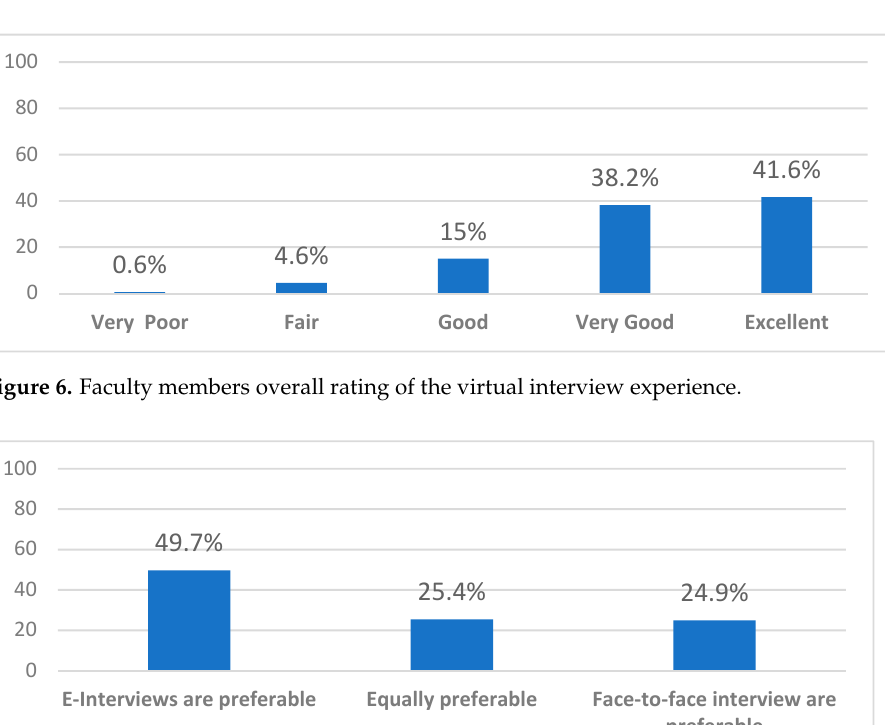
Figure 5. Faculty members’ (mean) satisfaction rate with virtual interviews domains of performance (maximum 5).